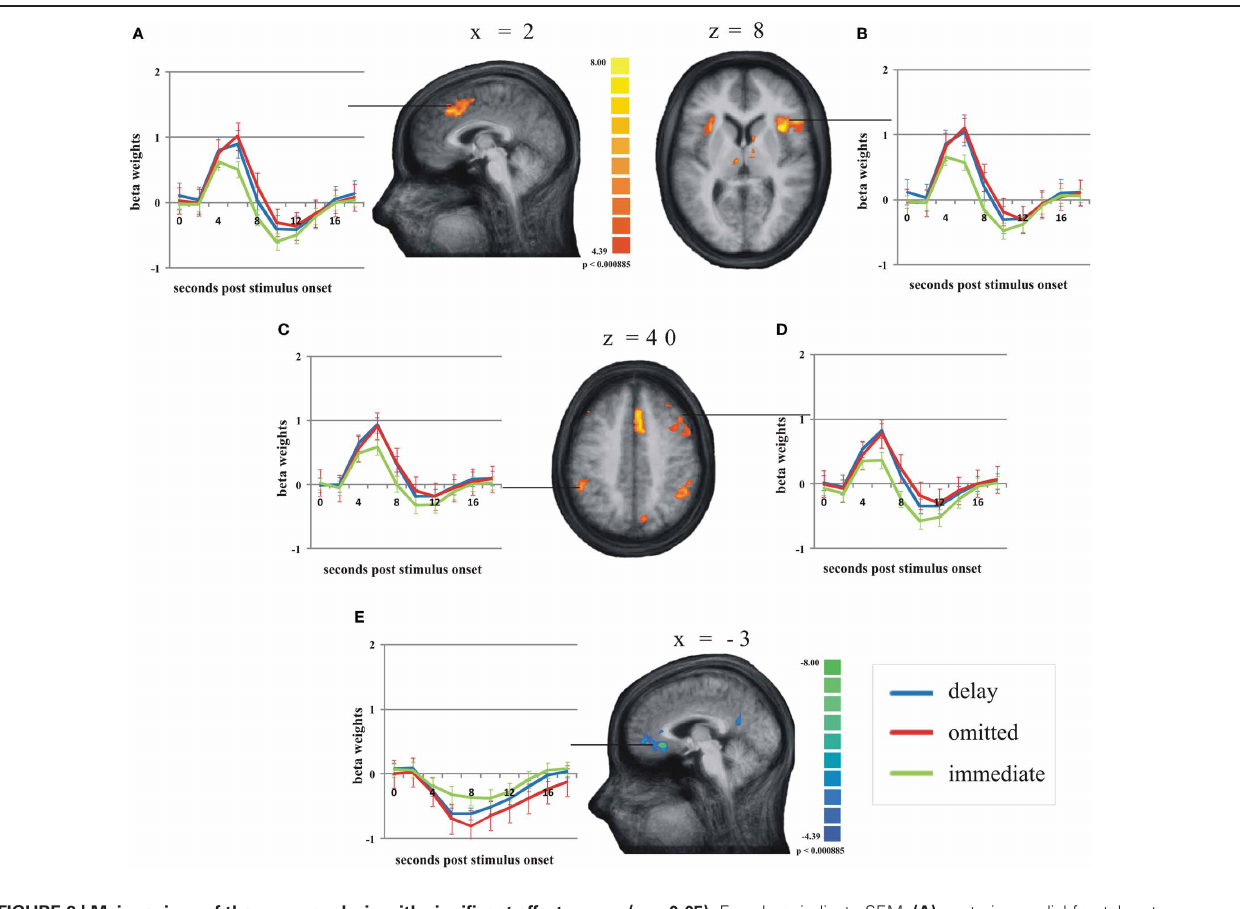
FIGURE 3 | Main regions of the group analysis with significant effects (activation/deactivation) during delayed (blue line) and omitted feedback (red line) compared to immediate feedback (green line)